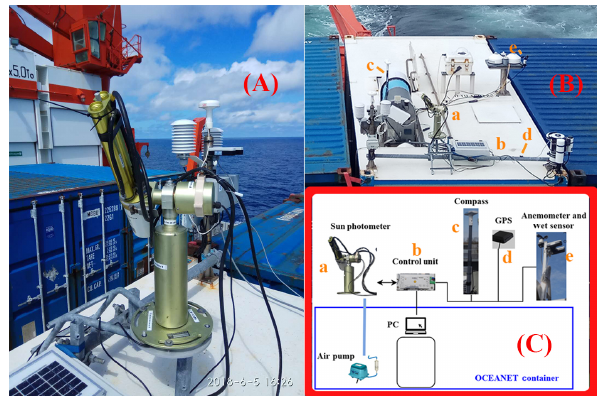
Figure 3. Shipborne Sun photometer CE318-T taking measure- ments on the RV Polarstern (A) , top view of the Sun photometer on the top of the container (B) and the sketch of the Sun photometer setup (C) . Lowercase letters (a–e) are used to relate the technical scheme (C) to the actual setup shown in panel (B)